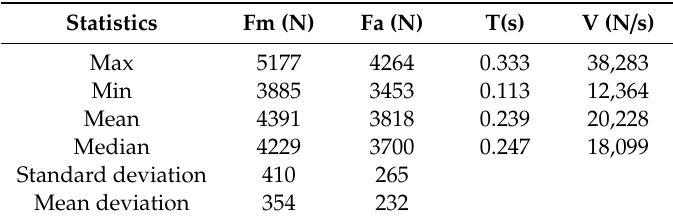
Table 7. Force statistics.